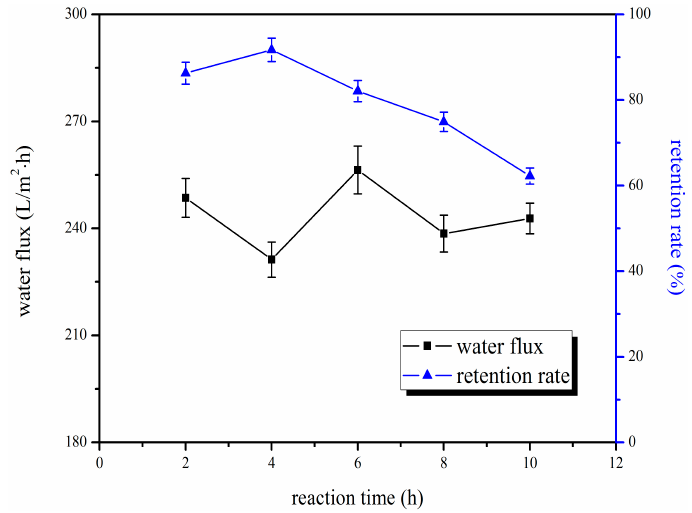
Figure 3. Effect of blending time on water flux and retention rate of BSA.